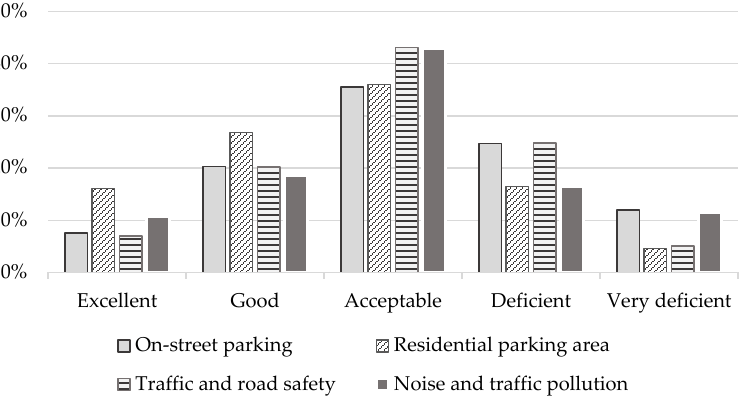
Figure 8. Problems associated with private vehicles in RMSC.